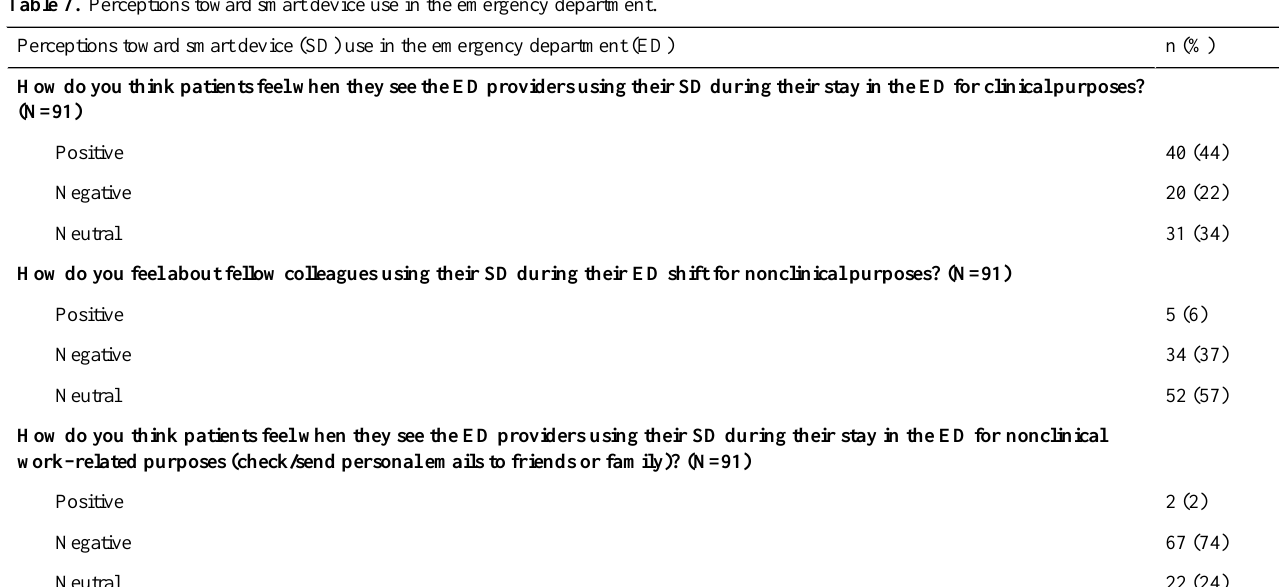
Table 7. Perceptions toward smart device use in the emergency department.